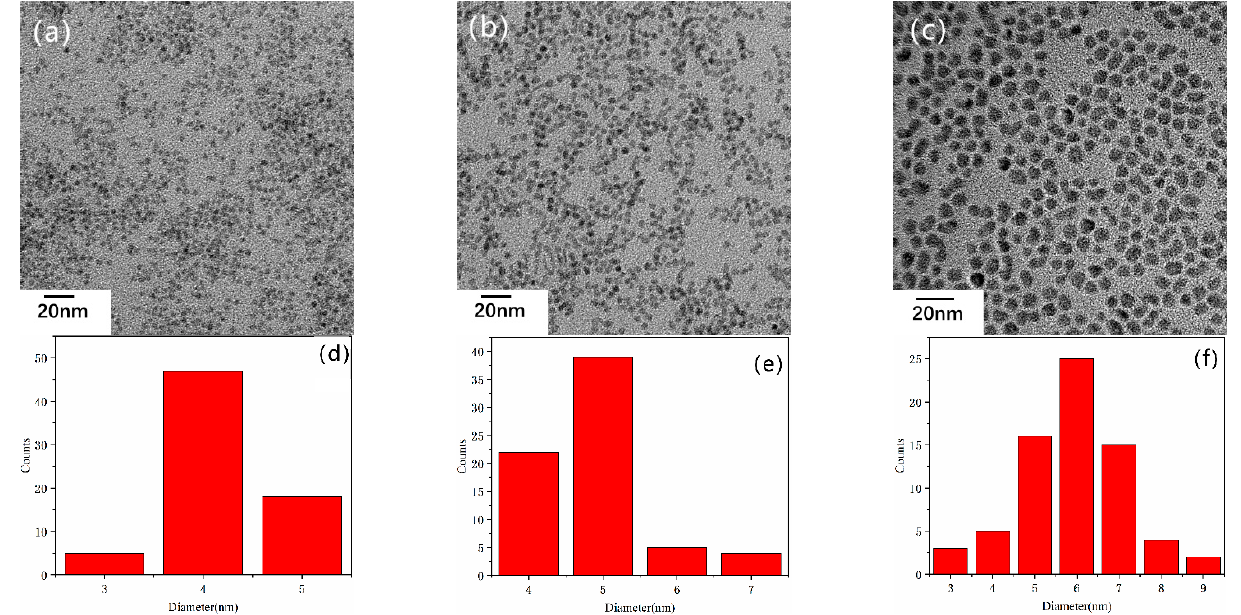
Figure 2. TEM images of ( a ) CdS ( b ) CdSe ( c ) CdTe NCs. (Scale bar 20 nm), particle size distribution of ( d ) CdS ( e ) CdSe ( f ) CdTe NCs.